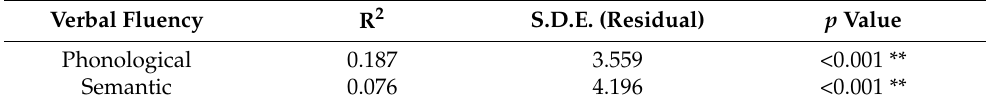
Table 6. Results of simple linear regression analysis to verify the model. p < 0.01 **.